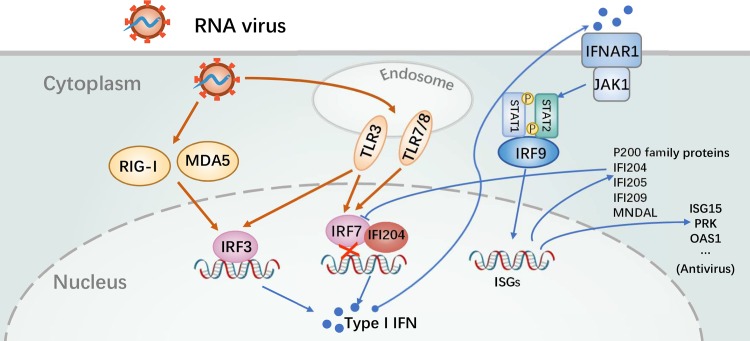
Proposed molecular mechanism for the function of p200 family proteins (IFI204) to inhibit IRF7-mediated activation of type I IFNs responses.Schematic diagram demonstrates the mechanism of p200 family proteins to suppress type I IFNs responses. Late after RNA virus infection, the highly expressed p200 family proteins, such as IFI204, interact with IRF7 in the nucleus and such interactions lead to the negative regulation of type I IFNs responses.